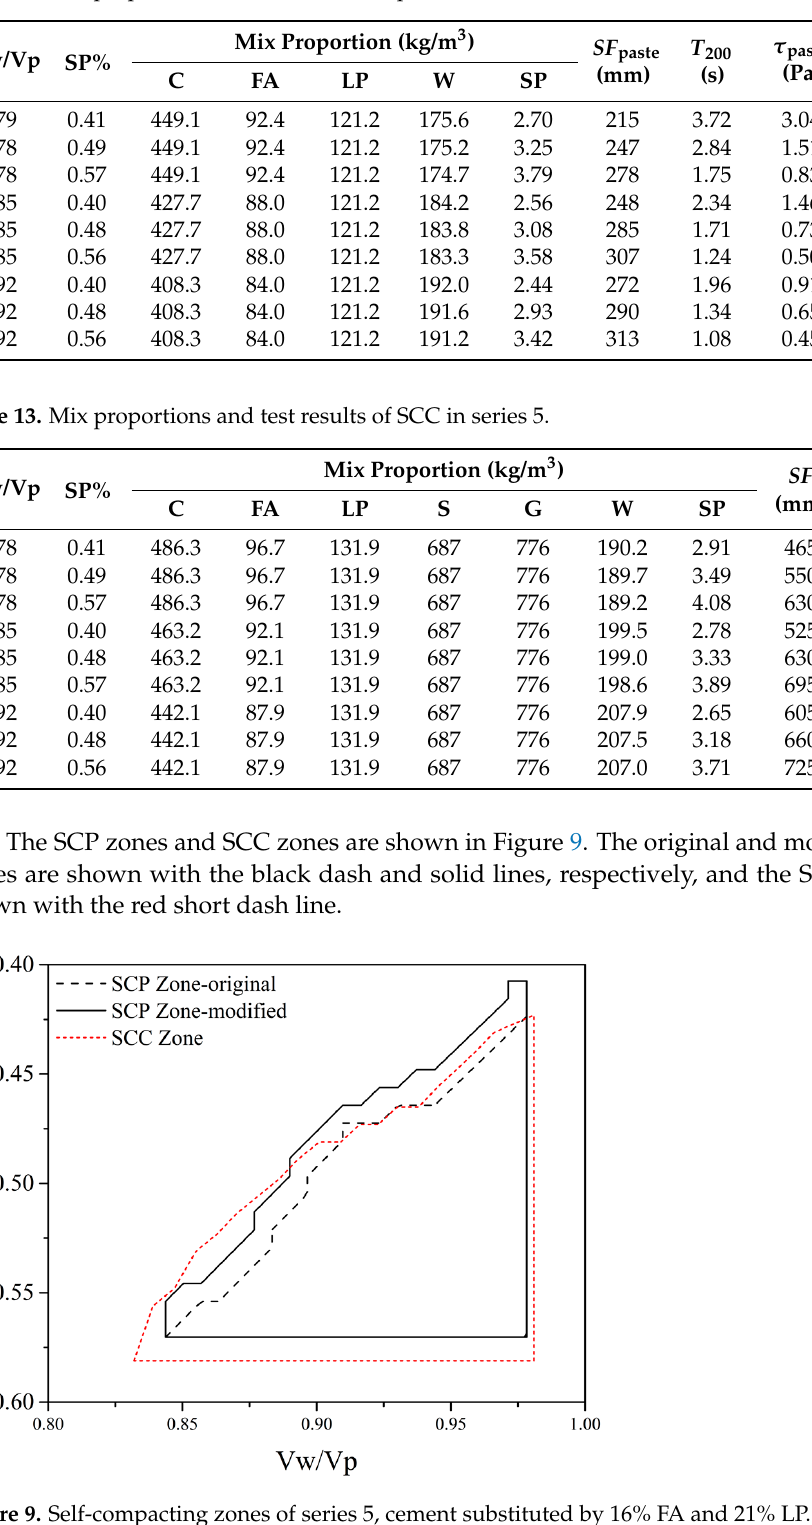
Table 12. Mix proportions and test results of paste in series 5.